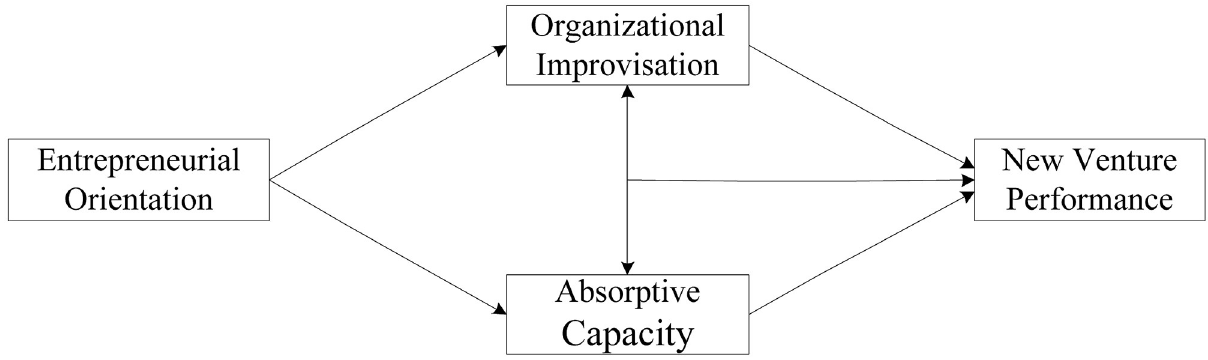
Fig 1. Theoretical and conceptual